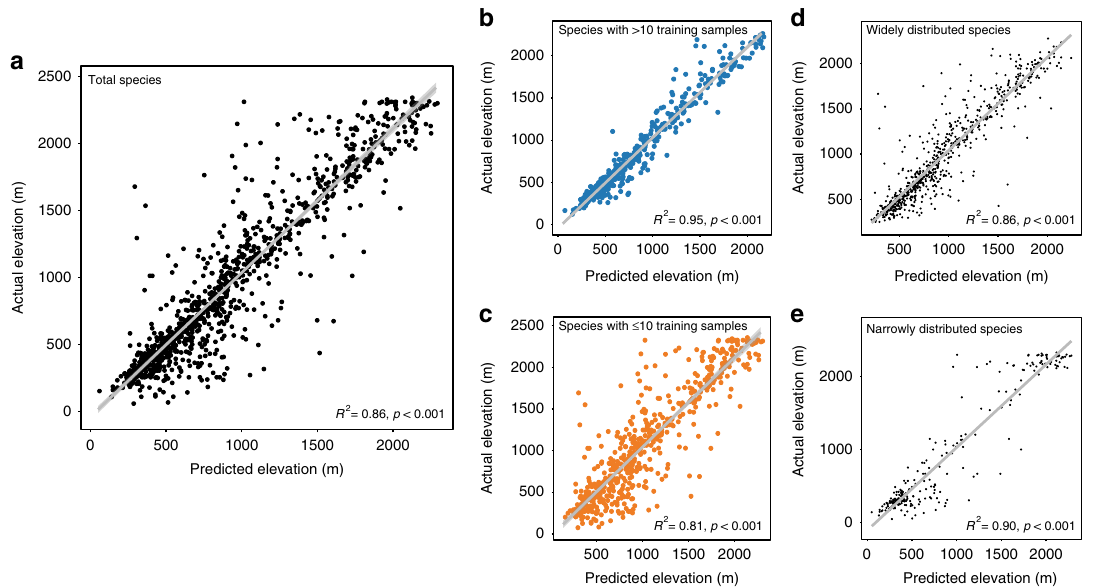
Fig. 1 Comparison between the predicted and actual mean elevations of moth species. a There were 1951 and 1047 species in the complete and validation datasets, respectively. b For a subset of the data with >10 images in the training dataset, there were 500 and 480 species in the training and validation dataset, respectively. c For the subset of species with ≤ 10 images in the training dataset, there were 1451 and 567 species in the training and validation dataset, respectively. d For the subset of species with larger elevational distribution ranges (range size larger than the median size), there were 976 and 745 species in the training and validation dataset, respectively. e For the subset of species with smaller elevational distribution ranges (range size smaller than the median size), there were 975 and 302 species in the training and validation dataset, respectively. The results of a GLMM controlling for phylogenetic effects are shown at the bottom of each fi gure. Source data are provided as a Source Data fi